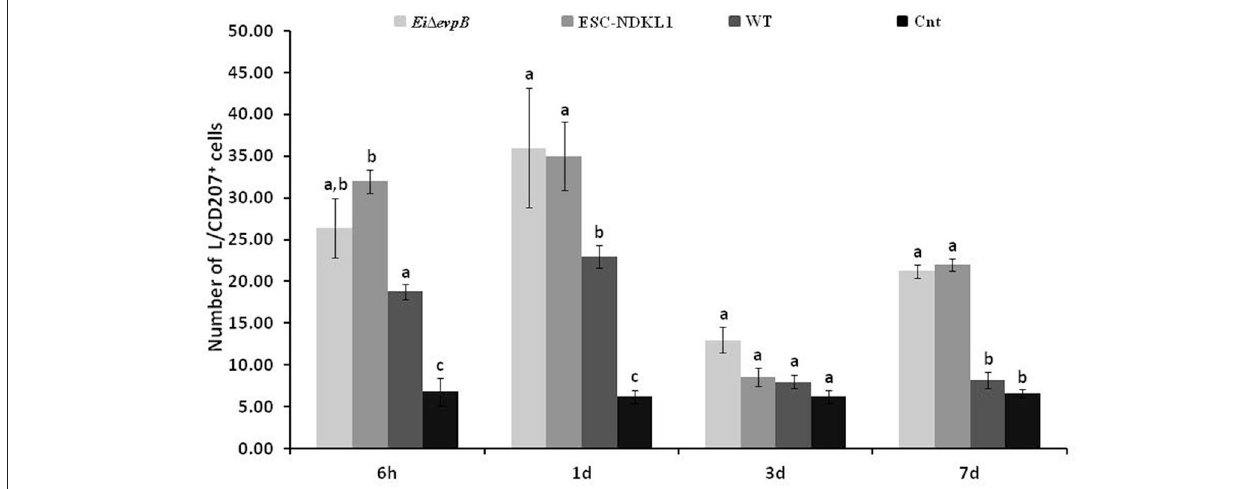
FIGURE 5 | The kinetics of L/CD207 + cells numbers in the spleen of catfish challenged with E. ictaluri LAV and WT strains. The letters (a, b, c) show the significant differences between groups at each time point ( P < 0.05). The data represented the mean of five fish ± SD.